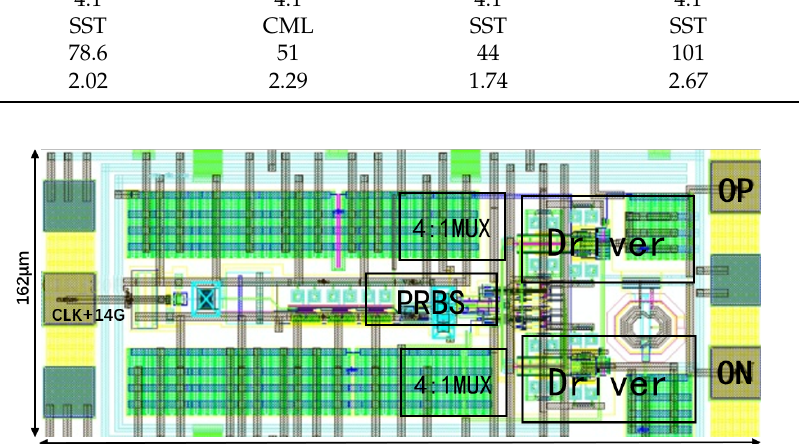
Figure 17. The layout picture.